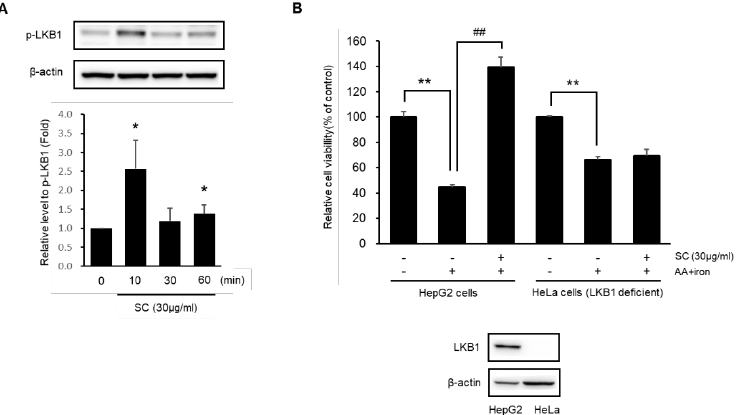
Figure 4. Effect of SC on LKB1 activation. ( A ) Immunoblotting analysis of p-LKB1 was performed with HepG2 cell lysates. The cells were treated as described in Figure 3A, and incubated for the indicated time. Expression of p-LKB1 represents the mean ± SD of three replicates (* p < 0.05 between control and SC-treated cells). ( B ) Effect of SC on the cytotoxicity caused by AA + iron on HepG2 and LKB1-deficient HeLa cells. HepG2 and HeLa Cells were incubated as in Figure 1A. After incubation, an MTT assay was performed. Data represent the mean ± SD (** p < 0.01 between control and AA + iron-treated cells; ## p < 0.01 between AA + iron and AA + iron-treated cells with SC).